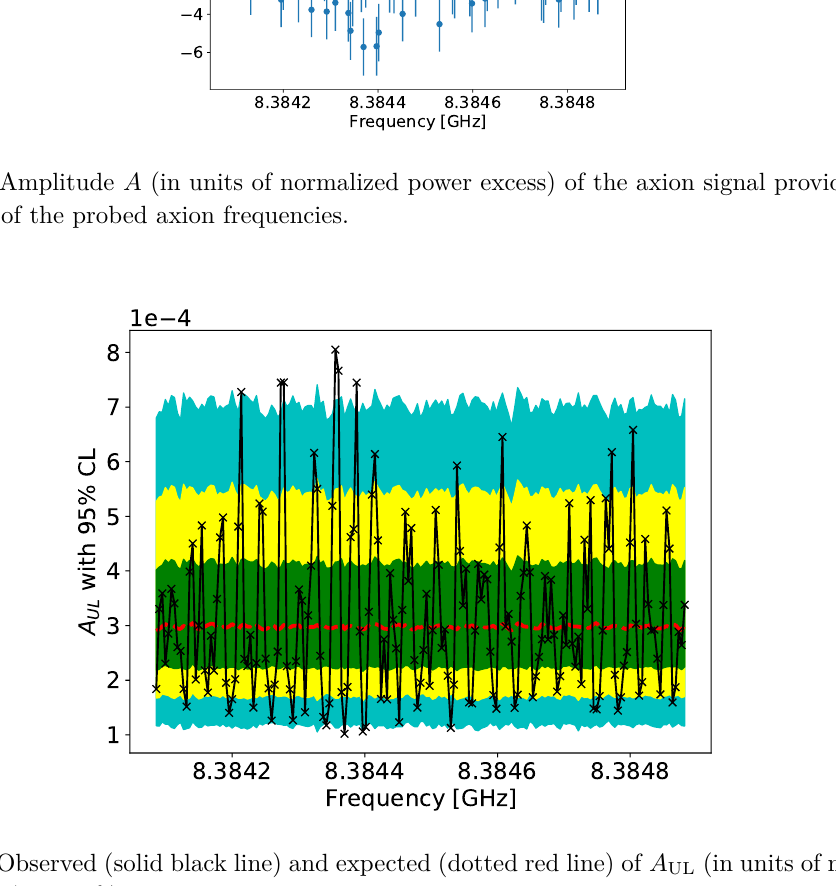
Figure 8 . Observed (solid black line) and expected (dotted red line) of A UL (in units of normalized power excess) for 95 % CL and the 1, 2 and 3 σ bands for the background-only